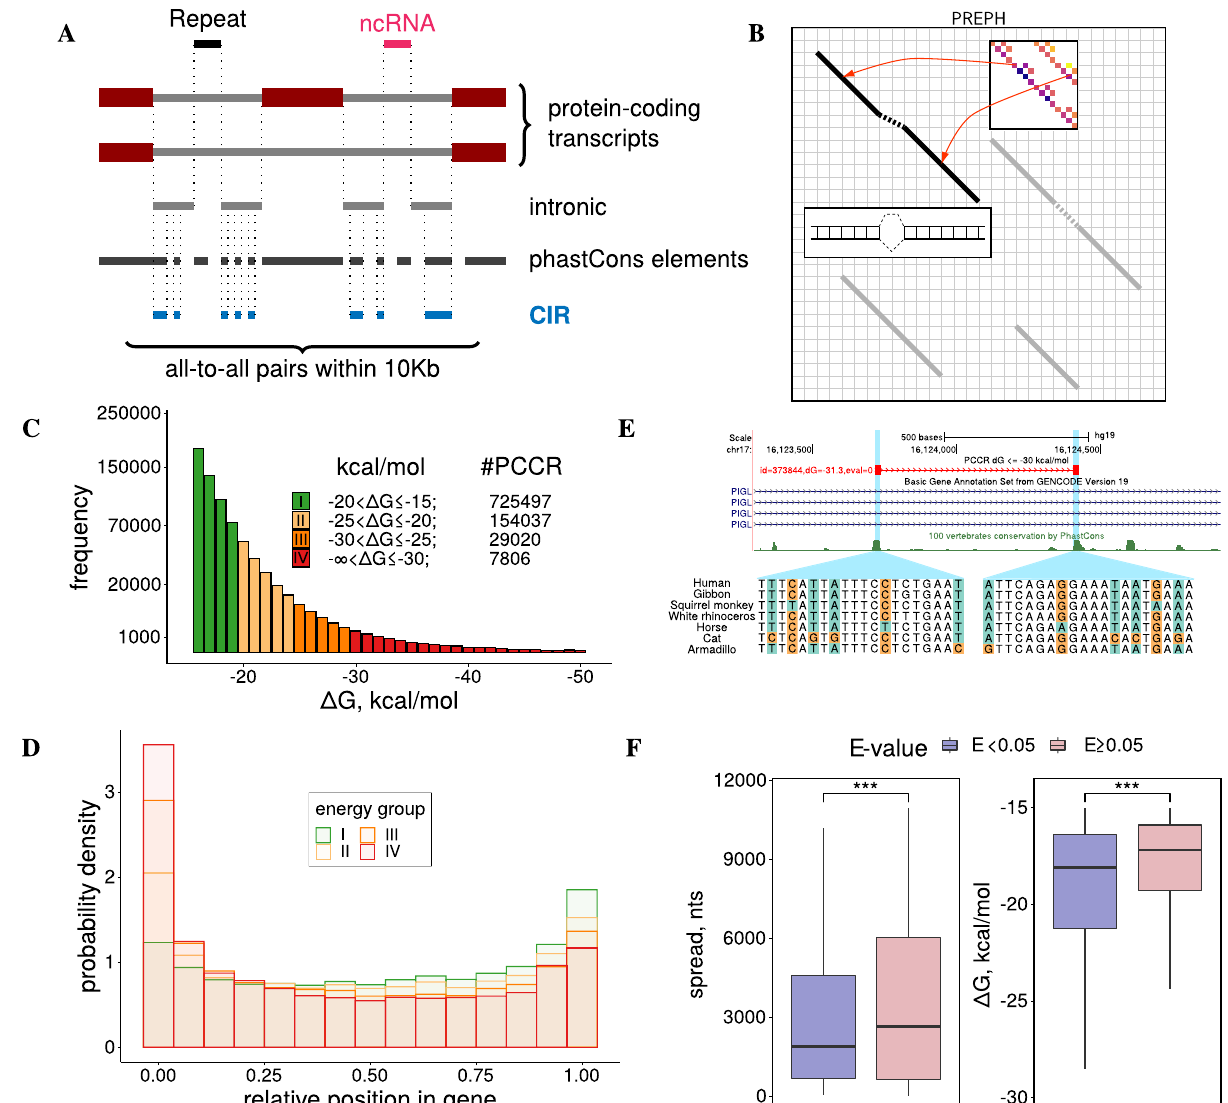
Fig. 1 Pairs of conserved complementary regions (PCCRs). A PCCRs are identi fi ed in conserved intronic regions (CIRs) that are <10,000 nts apart from each other. B PrePH computes the dynamic programming matrix based on the precomputed helix energies for all k -mers (inset) and energies of short internal loops and bulges (see Supplementary Methods for details). C The distribution of PCCR energies consists of four energy groups: group I ( − 20 < Δ G ≤ − 15 kcal/mol), group II ( − 25 < Δ G ≤ − 20 kcal/mol), group III ( − 30 < Δ G ≤ − 25 kcal/mol), and group IV ( Δ G ≤ − 30 kcal/mol). D The distribution of p , relative position of a PCCR in the gene. E Multiple independent compensatory substitutions support long-range RNA structure in the on average less spread and more stable than PCCRs with insigni fi cant nucleotide covariations ( E value ≥ 0.05, n = 905942); two-sided Mann – Whitney test; *** denotes a statistically discernible difference at the 0.1% signi fi cance